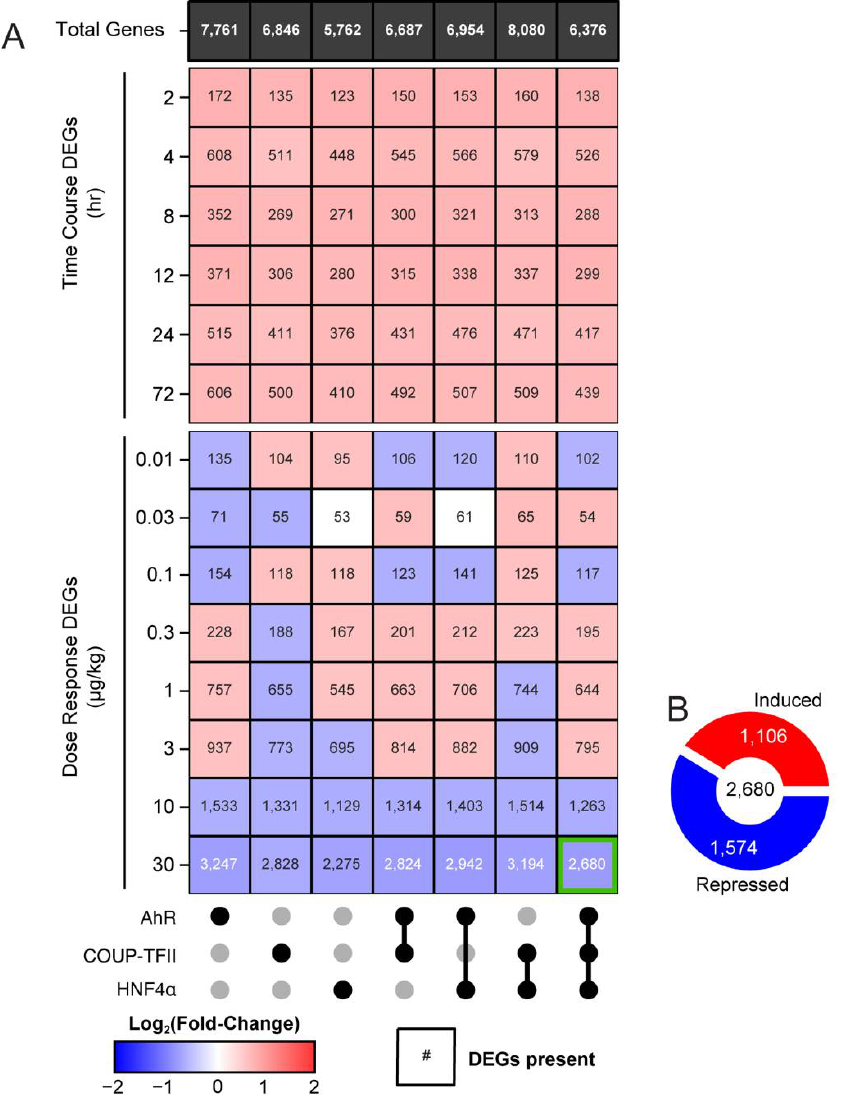
Figure 5. Gene expression of putative co-regulated genes. ( A ) The total number of genes with at least one enriched peak (black row) was determined for each transcription factor and their intersection (black dots). Differential gene expression (heatmap) was assessed for the transcription factor bound genes in a time course (GSE109863) and dose response (GSE87519) RNAseq dataset. The number within each tile provides the total number of differentially expressed genes (DEGs) for each individual transcription factor and their intersections. The color of the heatmap tile denotes the median Log 2 fold-change of differentially expressed genes. ( B ) DEGs putatively co-regulated by AhR, COUP-TFII, and HNF4 α in mice gavaged with 30 µ g/kg every 4 days for 28 days were further evaluated (genes represented in green square). The number of induced and repressed DEGs are shown in red and blue,